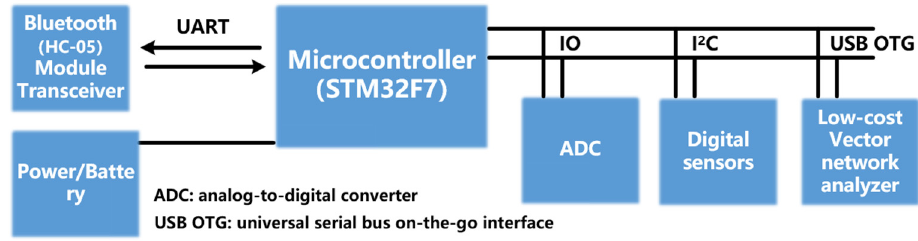
Figure 15. Dynamic spectrum detection and data transmission system architecture.